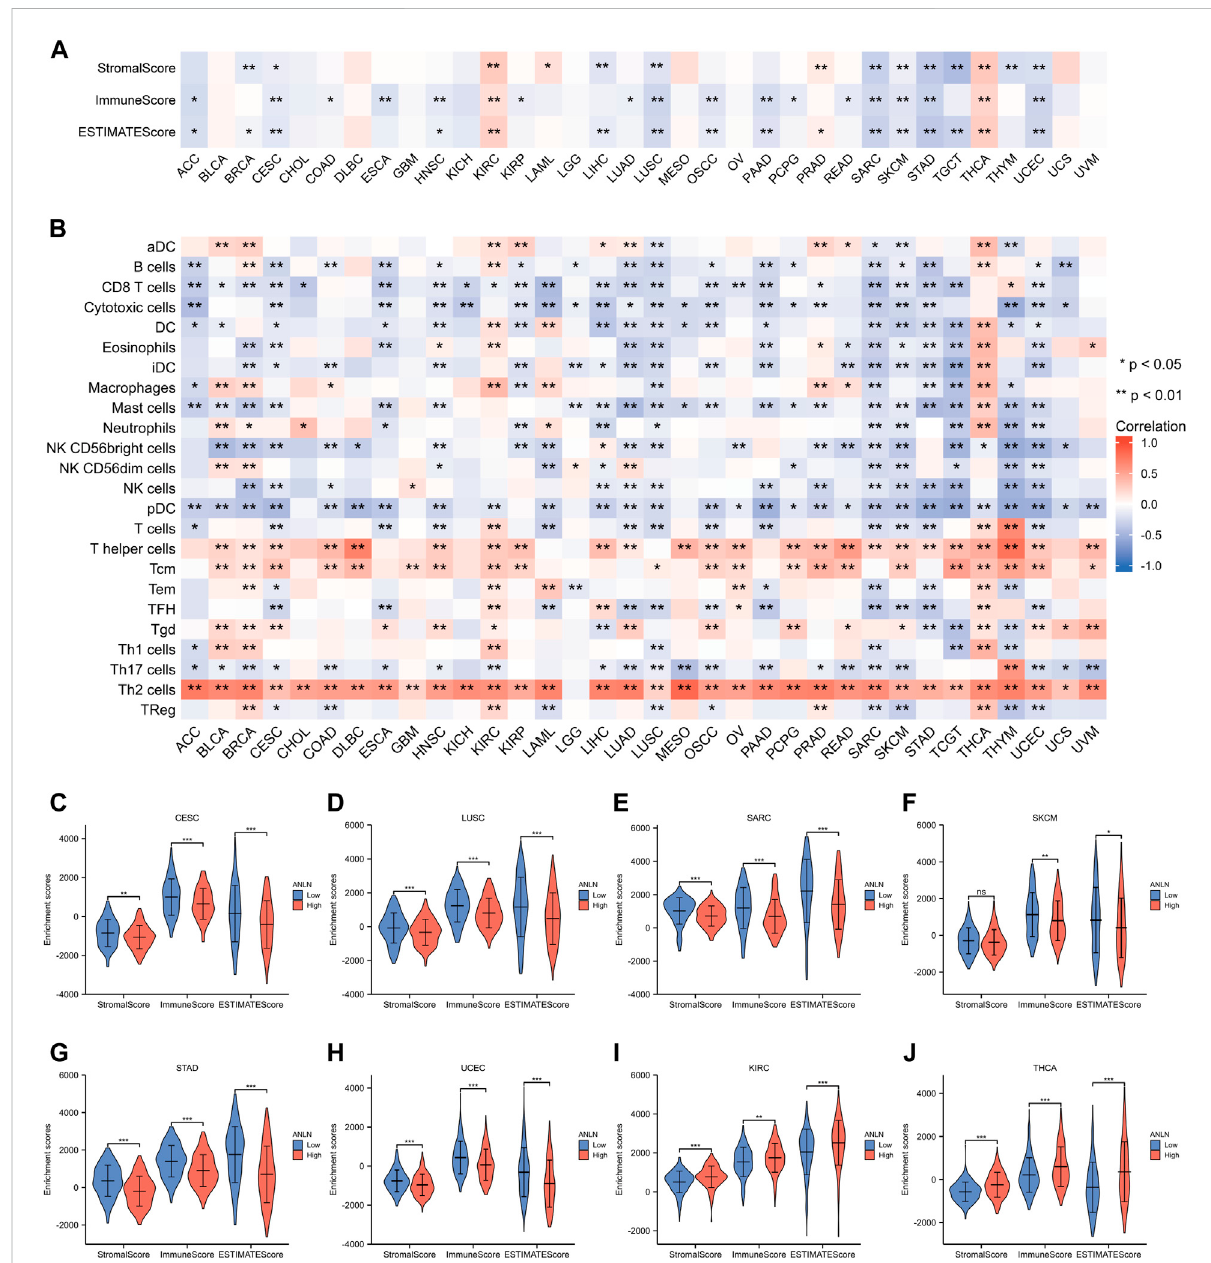
FIGURE 9 Associations between immune cell in fi ltration levels and ANLN expression in pan-cancer. (A) The correlation of ANLN expression and immune in fi ltration using the ESTIMATE algorithm. (B) The correlation of ANLN expression and immune in fi ltration using the ssGSEA algorithm. The distributionof immune scores, stromal scores, and ESTIMATE scores betweenANLN low and high groups in CESC (C) , LUSC (D) , SARC (E) , SKCM (F) , STAD (G) , UCEC (H) , KIRC (I) , and THCA (J)